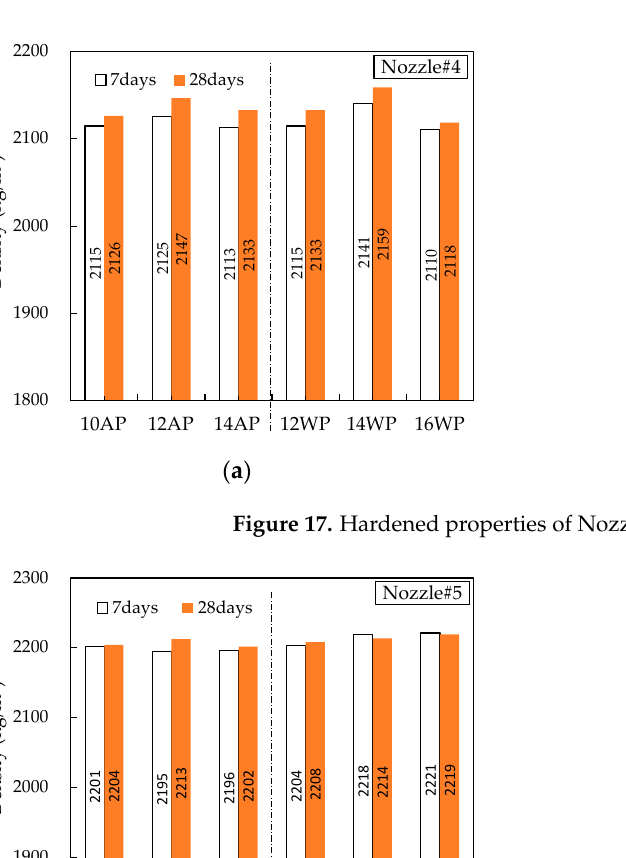
Figure 16. Hardened properties of Nozzle#3 specimens: (a) density; (b) compressive strength.